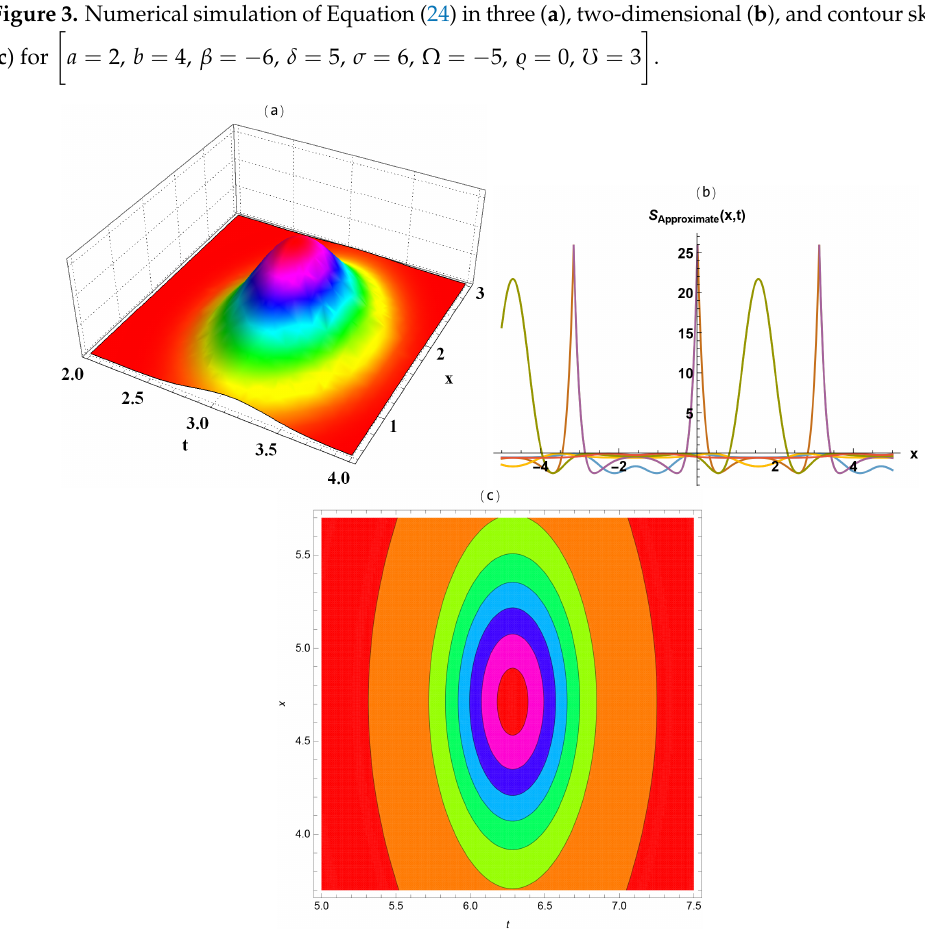
Figure 3. Numerical simulation of Equation (24) in three ( a ), two-dimensional ( b ), and contour sketches (cid:20) a = 2, b = 4, β = − 6, δ = 5, σ = 6, Ω = − 5, (cid:36) = 0, ( c ) for